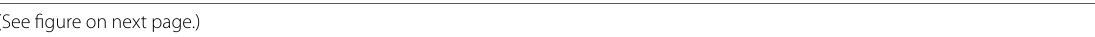
Fig. 1 A Overview of tectonic realms in the Geneva Basin for the FCC construction with analysed well and outcrop locations. Geophysical well-logs were digitized and analysed together with available rock core data from these wells. See Table 1 for well numbers and full well-IDs. The overlying Quaternary deposits are neglected for increased readability. The blue line depicts cross section A, the green line refers to cross section B (Figs. 5, 6). Note that the Salève and Mandallaz limestone as commonly referred to in technical reports are part of the Jura. FTB fold-and-thrust belt. B The white profile X–Y displays a large-scale cross section through the Geneva Basin and is based on chronostratigraphic units representing the vertical and spatial relationships of age-defined packages of lithologies in a geo-historical picture. The FCC’s current subsurface tunnel alignment is currently foreseen at a depth interval between 100 to 300 m ASL. The Burdigalian Molasse belongs to the Upper Marine Molasse and is hereby noted Marine Molasse. Data compiled, amended and modified after Bachmann & Müller, 1991; Charollais et al., 2013; Clerc & Moscariello, 2020; Deville et al., 1994; Haq et al., 1987; Kuhlemann & Kempf, 2002; Lemcke, 1988; Mastrangelo & Charollais, 2018; Moscariello, 2019, 2021; Zweigel et